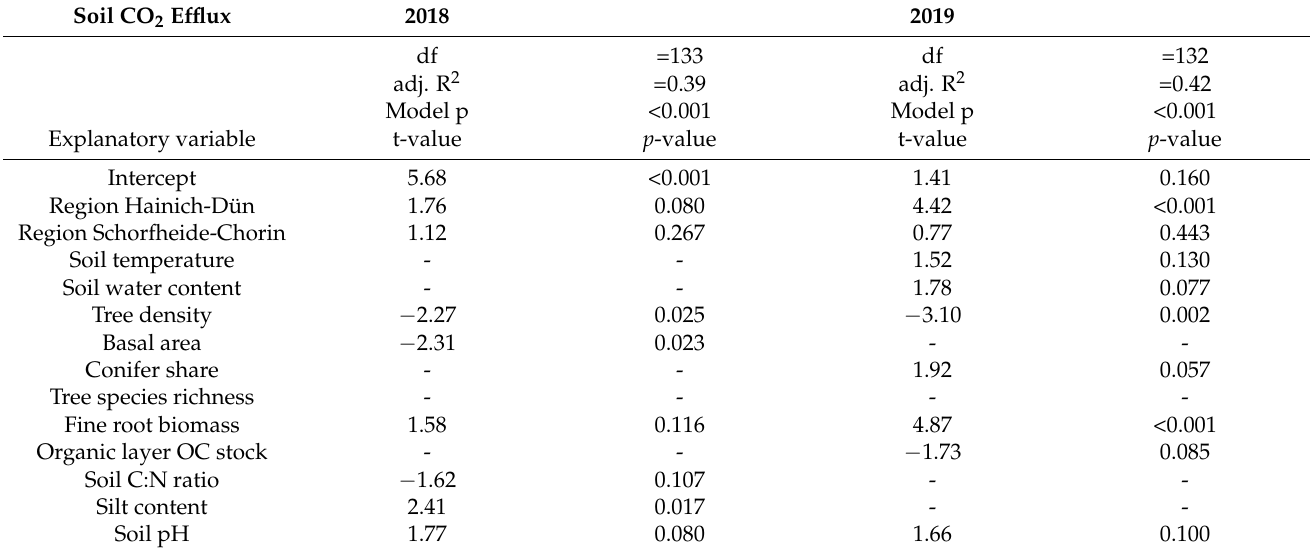
Table 3. ANCOVA models for soil CO 2 efflux in 2018 and in 2019. Full models were stepwise reduced. Study region effects are given relative to the Schwäbische-Alb region. Stand age, mean diameter at breast height, tree species richness and mineral soil OC stocks were never selected in the final